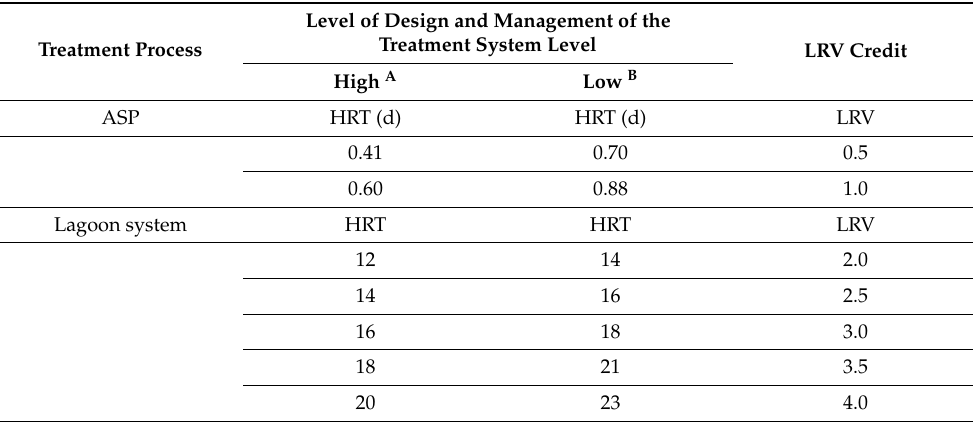
Table 4. Log reduction values (LRV) credits proposed for hydraulic retention times (HRT) in lagoon systems and activated sludge plants